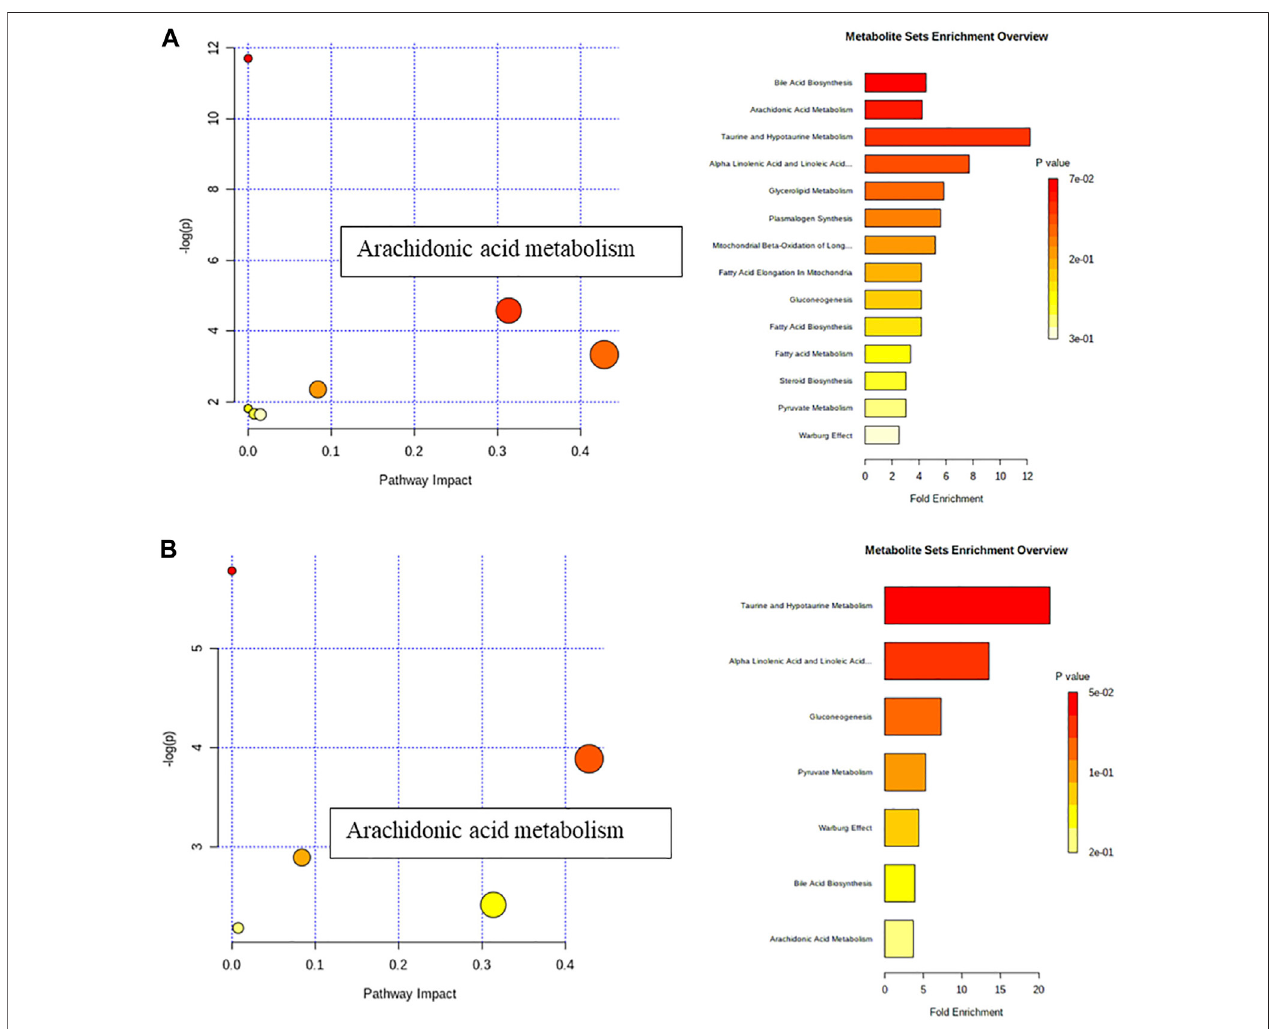
FIGURE 6 | Metabolic pathway analysis (A) Metabolic pathway analysis between Control and Model group (B) Metabolic pathway analysis between Model and GZFL group.